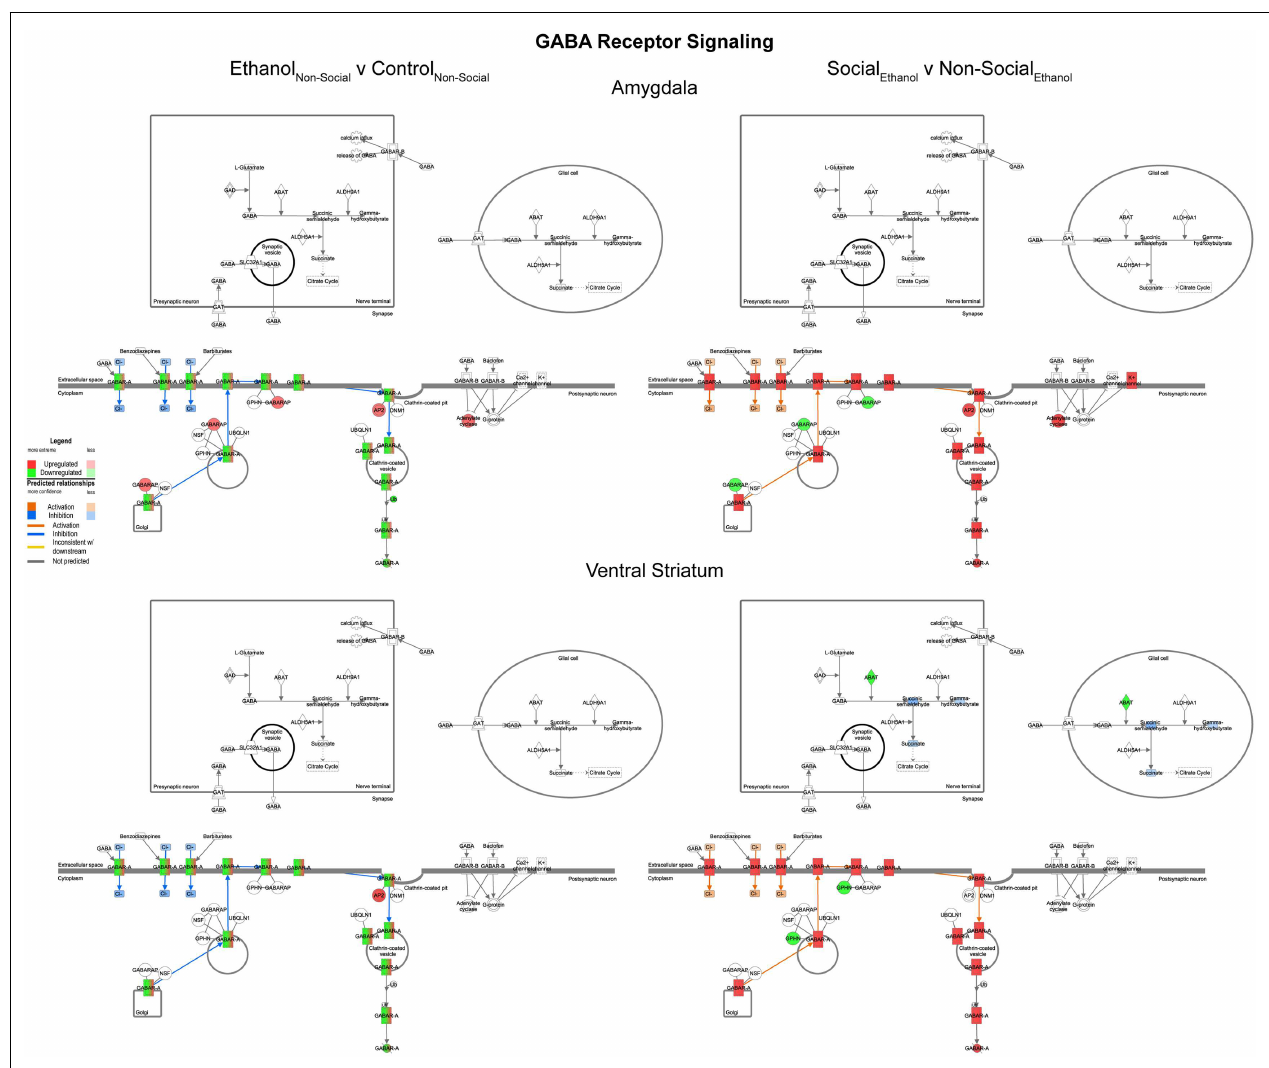
FIGURE 7 | Ethanol and social enrichment effects on GABA receptor signaling . Conventions same as Figure 3 . Note that prenatal ethanol exposure generally inhibits GABA signaling and is reversed following social enrichment. In some cases, due to the presence of multiple isoforms of a gene with the same name, multiple colors are contained within a